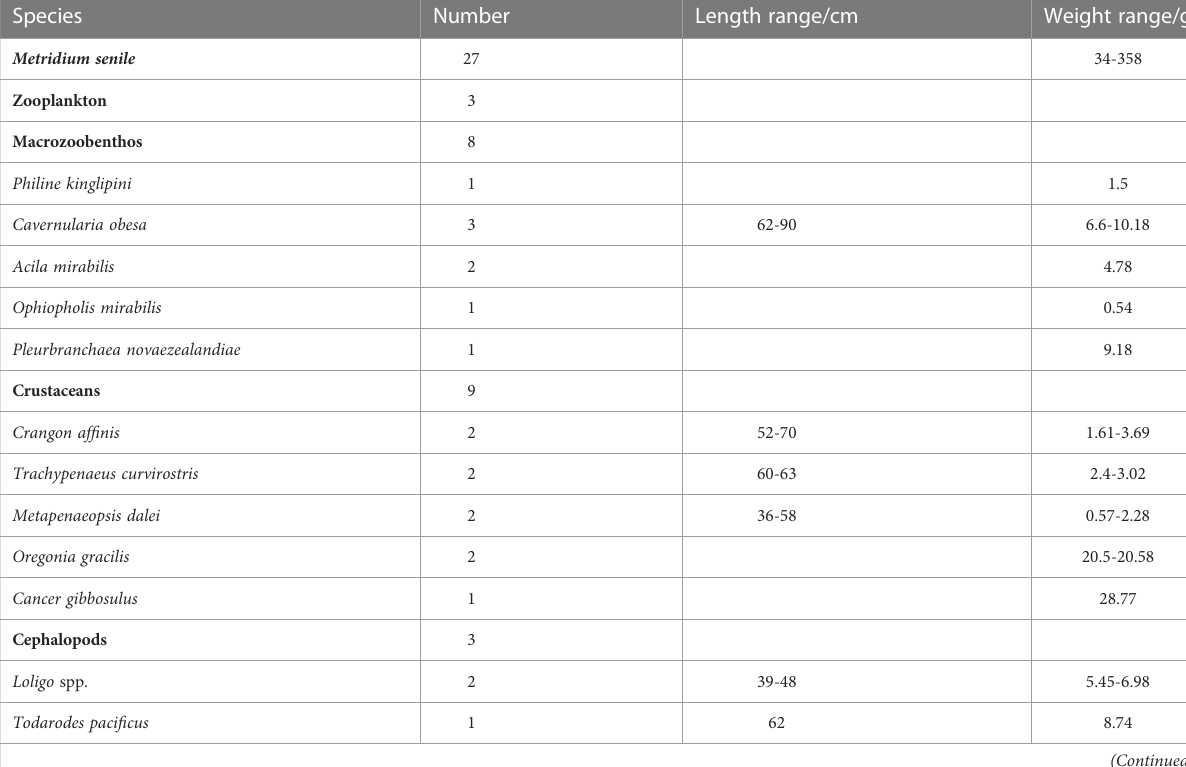
TABLE 1 Sample collection